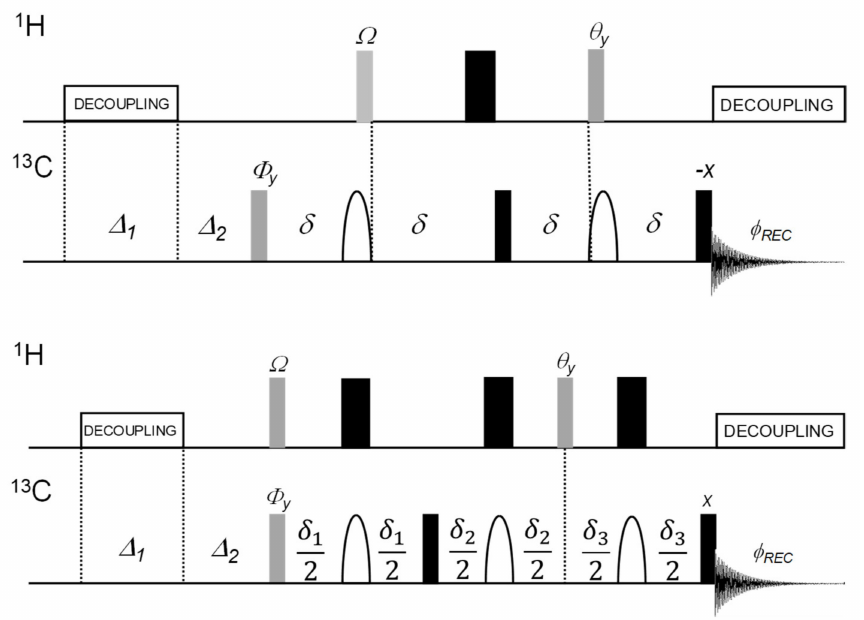
Figure 2. DEPTQ [11] ( top ) and DEPTQ + pulse sequences ( bottom ) for editing CH n multiplicities. The first adjustable proton pulse Ω and the editing pulse θ are set to 45 ◦ and 90 o , respectively, for a DEPTQ90 (DEPTQ90 45 ) and to 90 ◦ and 135 ◦ , respectively, for a DEPTQ135 (DEPTQ135 90 ), and the delay δ is adjusted to 1/(2 * 1 J CH ). The DEPTQ90 45 spectrum, showing exclusively the Cq and CH signals with opposite phases, and the DEPTQ135 90 spectrum, are subtracted from each other results in a CH 2 /CH 3 edited spectrum with the signals of the two carbon types with opposite phases [11]. The 13 C 180 ◦ (refocusing) pulses are composite smoothed chirp pulses (2 ms total duration, 60 kHz sweep width). The initial 13 C 90 ◦ pulse may be replaced by a variable ϕ pulse, adjustable for maximum sensitivity (Ernst angle). An additional 90 ◦ 13 C pulse prior to data acquisition re-establishes the residual 13 C- z magnetization left with the initial 13 C pulse. In the DEPTQ + , compared to the original DEPTQ version [10,11], the first evolution delay δ is omitted, and the remaining three evolution periods are defined as spin echoes, thus allowing different values for δ 1 , δ 2 , and δ 3 to be used. The first adjustable proton pulse Ω and the editing pulse θ are set to 45 ◦ and 90 ◦ , respectively, for a DEPTQ + 90 (DEPTQ + 90 45 ) and to 90 ◦ and 45 o , respectively, for a DEPTQ + 45 (DEPTQ + 45 90